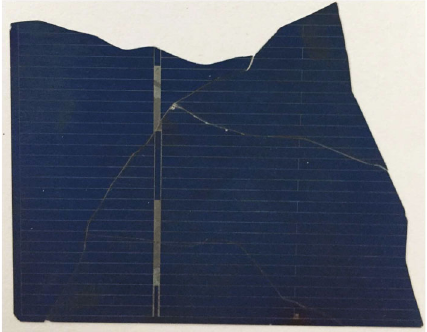
Figure 4: Top part of solar cell after removing silver electrodes and lead.